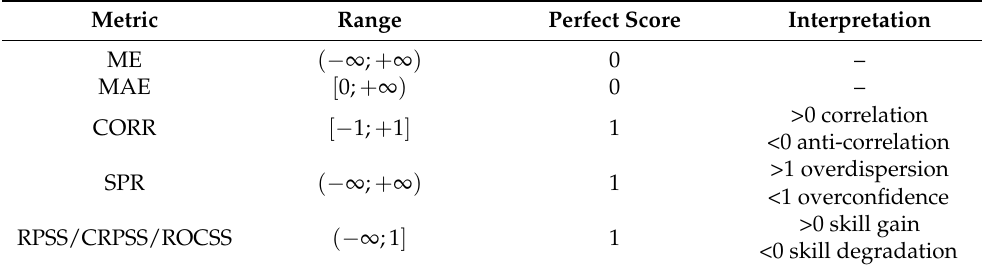
Table 1. Summary of forecast verification metrics used in this study, reporting the range of possible values, the score representing a perfect forecast and the main guidelines for result interpretation. In the cases of ME and MAE no interpretation notes are needed.